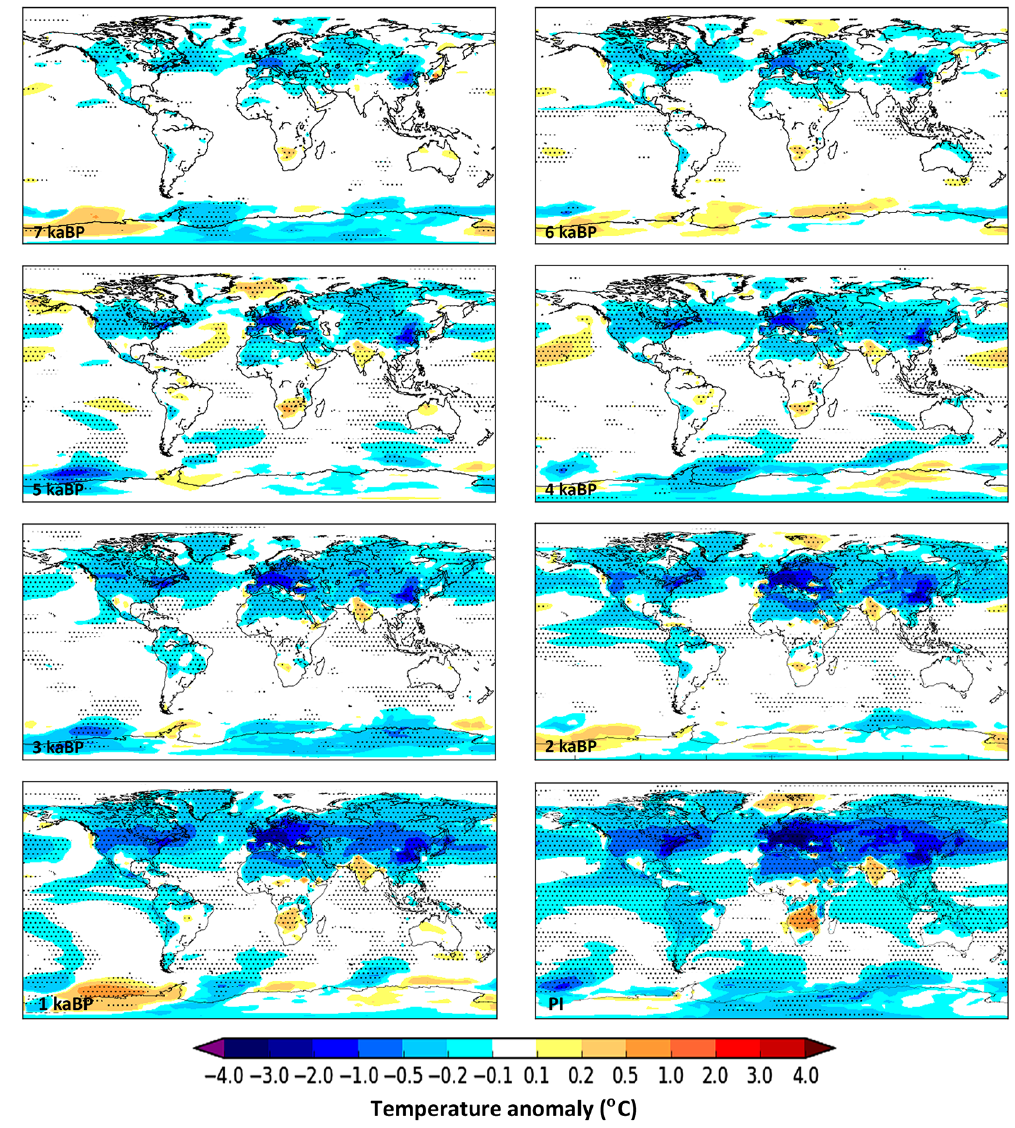
Figure 2. JJA temperature anomalies ( ◦ C) for KK10 minus control at time slices from the late pre-industrial period (1850CE) to 7kaBP. The stippling indicates grid boxes where the anomalies are significant at the 95% level using Wilcoxon rank sum statistical